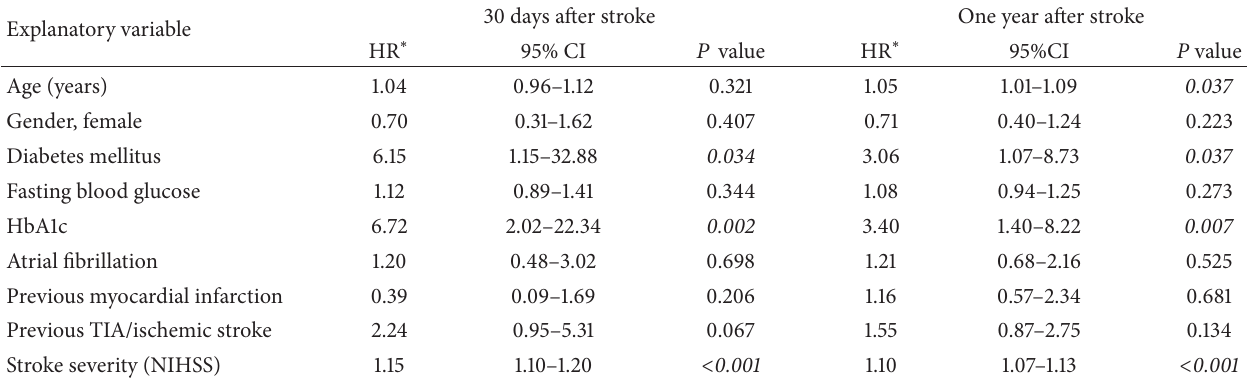
Table 2: Multiple logistic regression analysis showing the relationship between survival and explanatory variables.